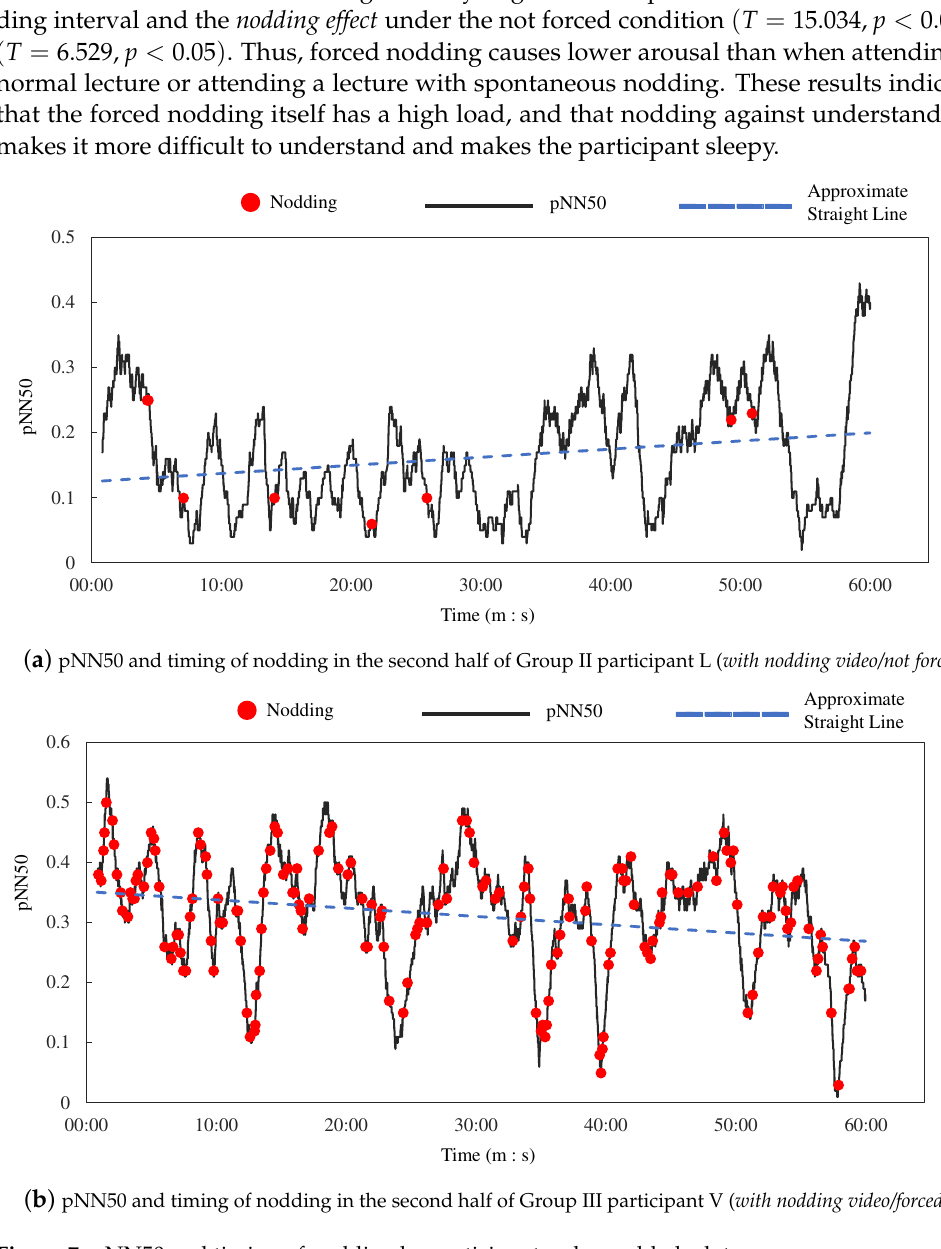
Figure 7. pNN50 and timing of nodding by participants who nodded a